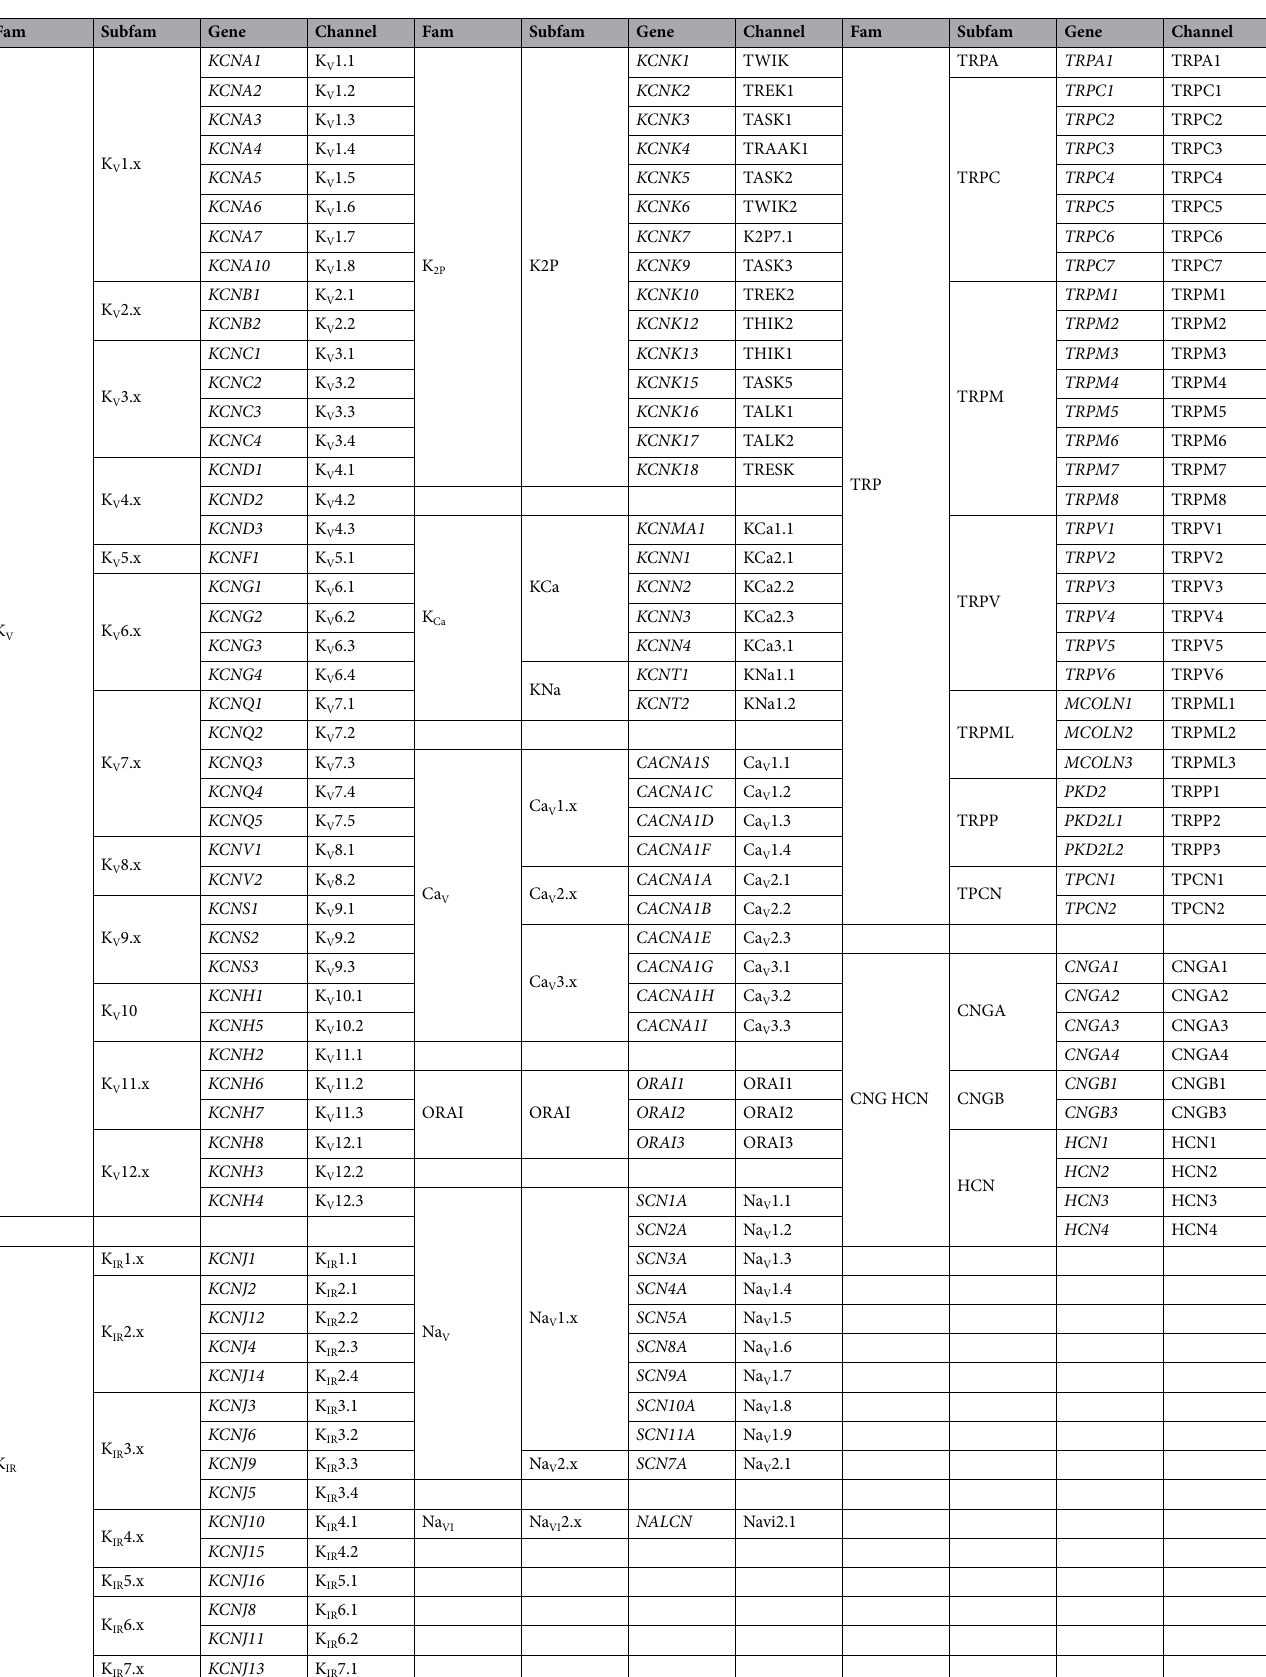
Table 1. Ion channel encoding genes and the corresponding cationic channel